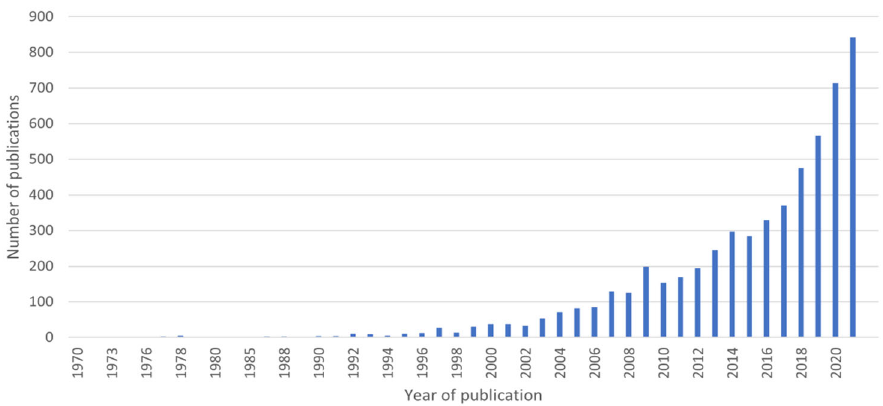
Figure 2. Documents published from 1970 to 2021 under the search criterion [TITLE-ABS-KEY (“advanced” AND “oxidation” AND “processes” AND “wastewater”)].